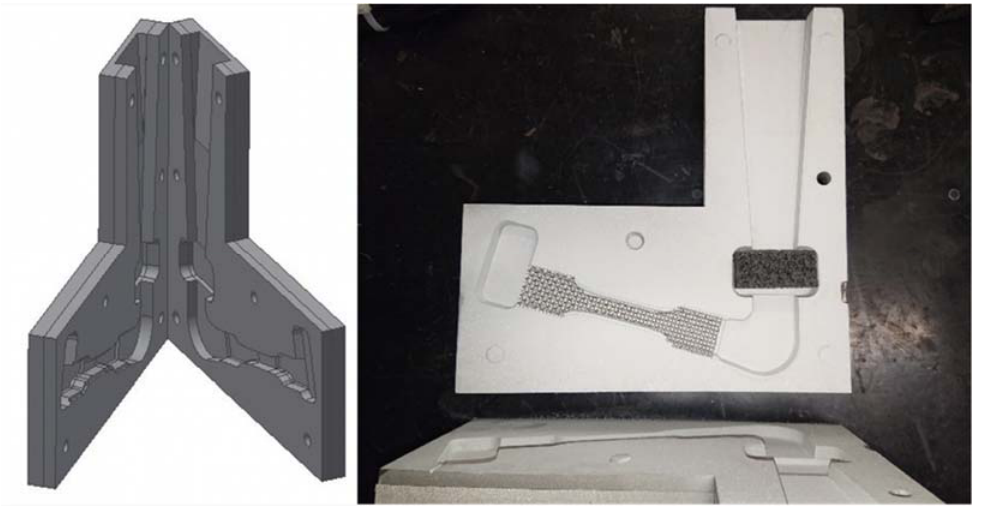
Figure 1: Mold geometry with insert and filter positioning